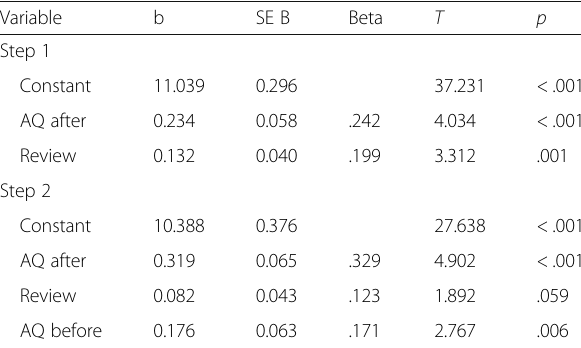
Table 6 Hierarchical regression analysis to assess the exclusive contribution of advance quizzing before learning to the prediction of “ Introduction to Memory ” exam performance